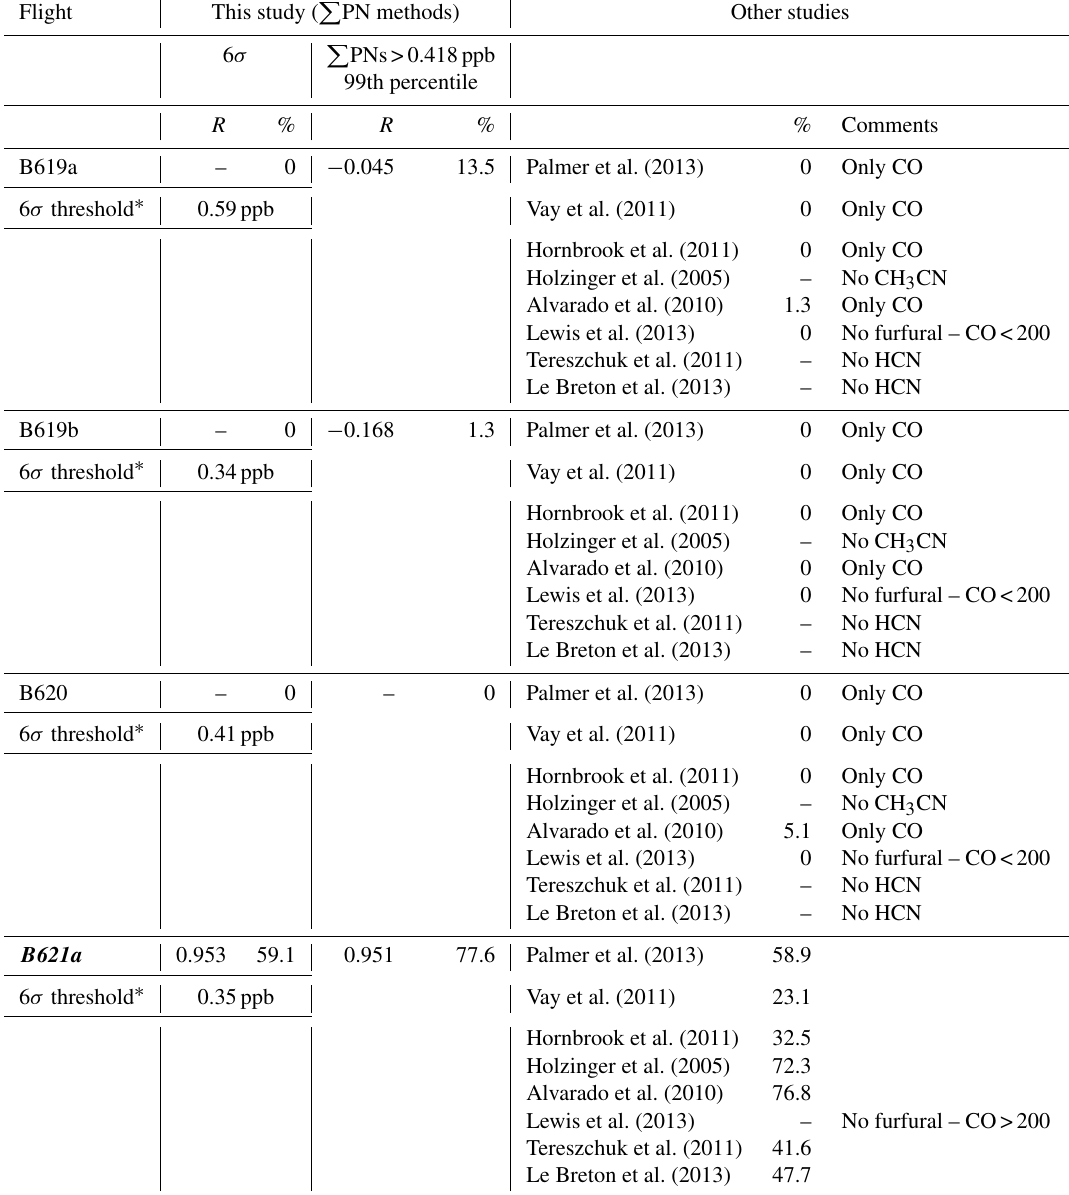
Table 3. Correlation coefficient ( R ) and percentage (%) of each flight of the BORTAS campaign selected as BB plume using both the P PN methods (6 σ and 99th percentile thresholds) and percentage (%) of BB plume evaluated for each BORTAS flight using the methods applied in other studies. In bold-italic we highlighted three flights with evidence of sampled significant BB